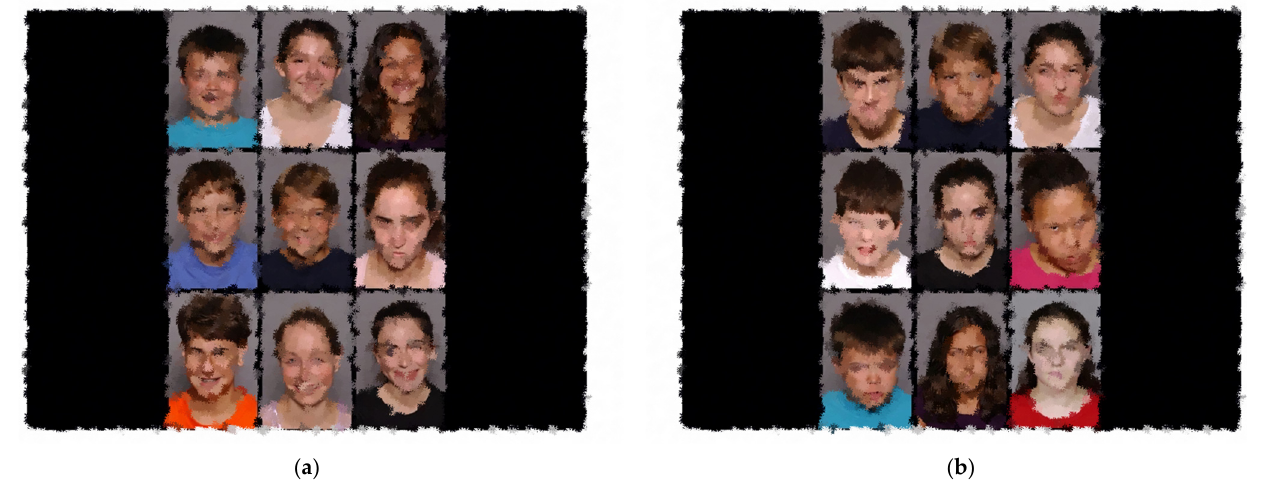
Figure 1. Masked example of two sets of photographs, from the Threat Detection Behavior Instru- ments, where: ( a ) assesses threat detection, through a matrix composed of one target photograph— angry face—and eight distractor photographs—happy faces; and ( b ) assesses inhibitory control of threat, through a matrix composed of one target photograph—neutral face—and eight distractor photographs—angry faces.